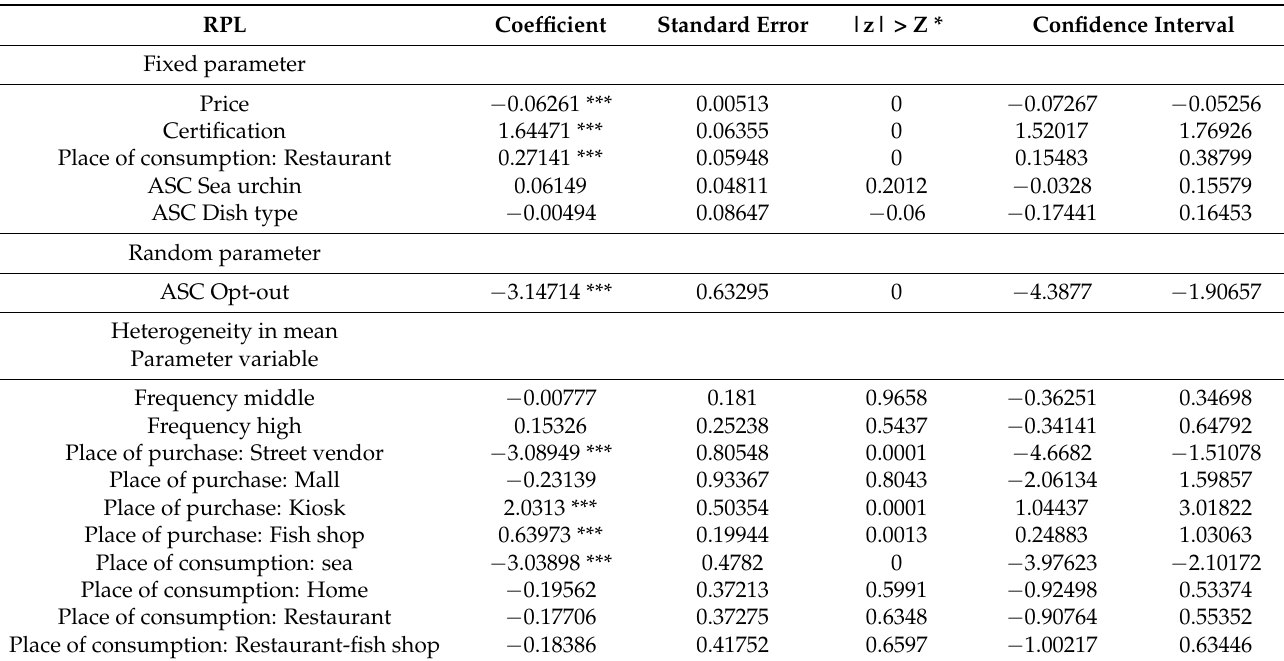
Table 12. Random parameter logit (RPL)